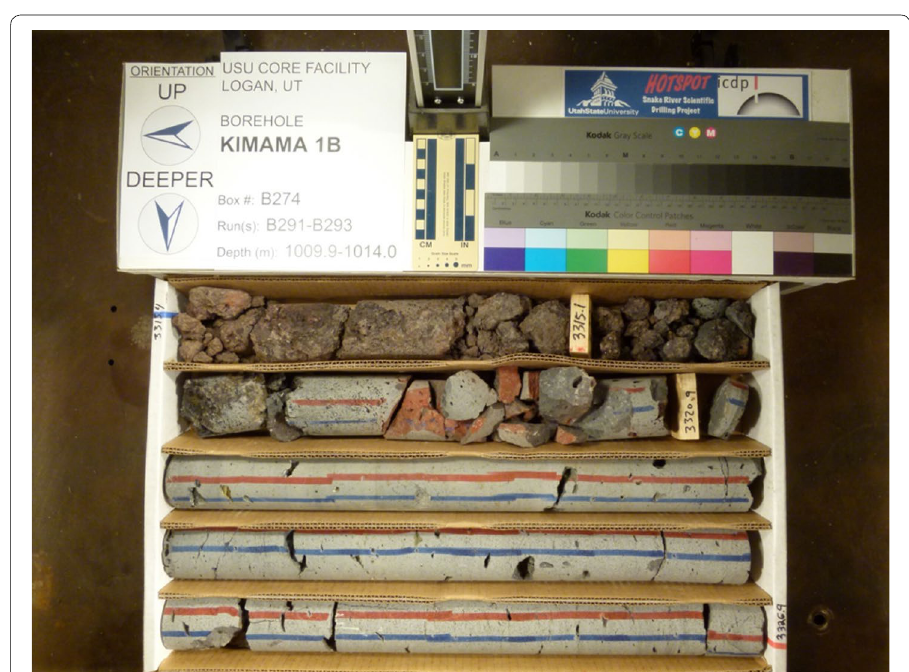
Fig. 6 Core from 1009 to 1014 m. Basalts are still gray with open vesicles, and no authigenic minerals are present